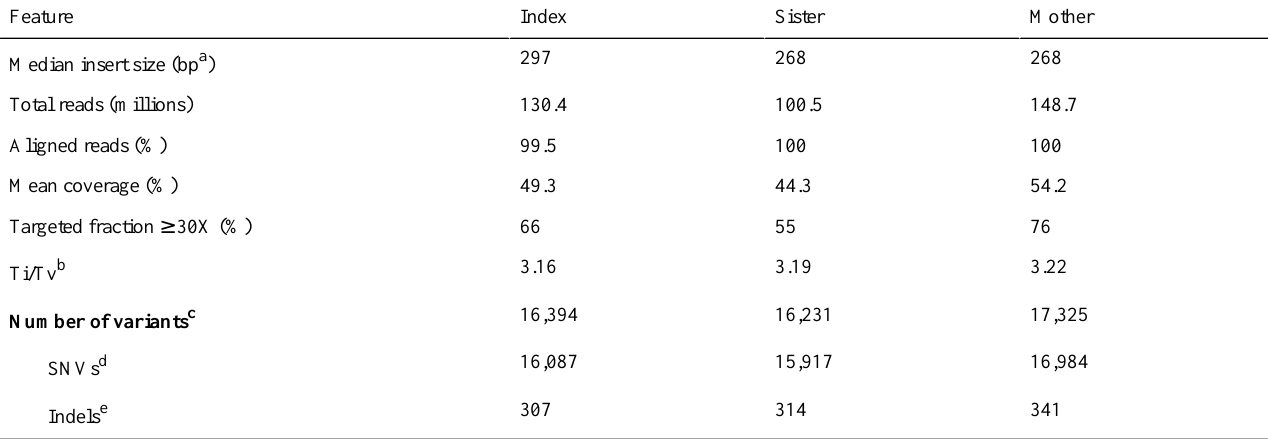
Table 1. Summary of the sequencing results in the validation